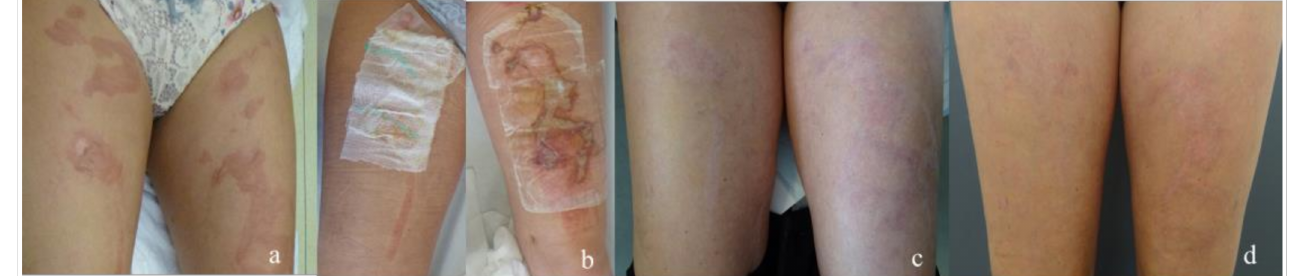
Figure 1. Patient with a superficial burn of the legs. ( a ) burn before debridement of the blisters ( b ) treatment of the left leg with epicite hydro® and the right leg with Suprathel ® ( c ) results after 3 months ( d ) results after 6 months.